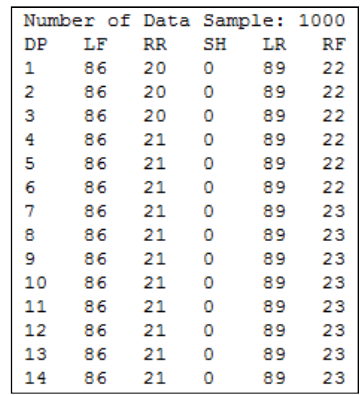
Figure 12. Part of a time series generated by a